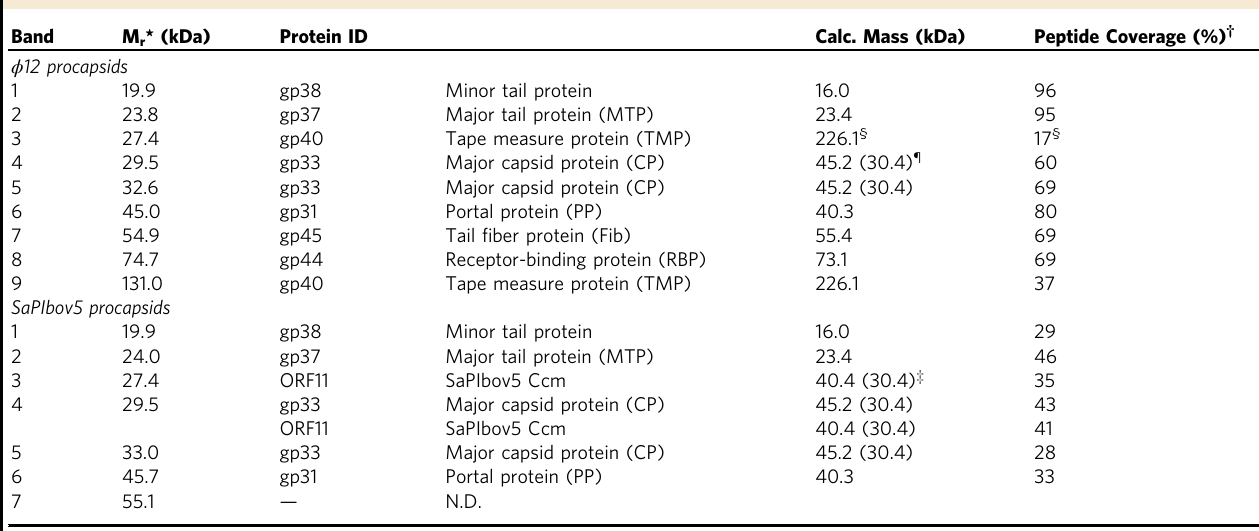
Table 1 Protein identi fi cation by MS/MS.